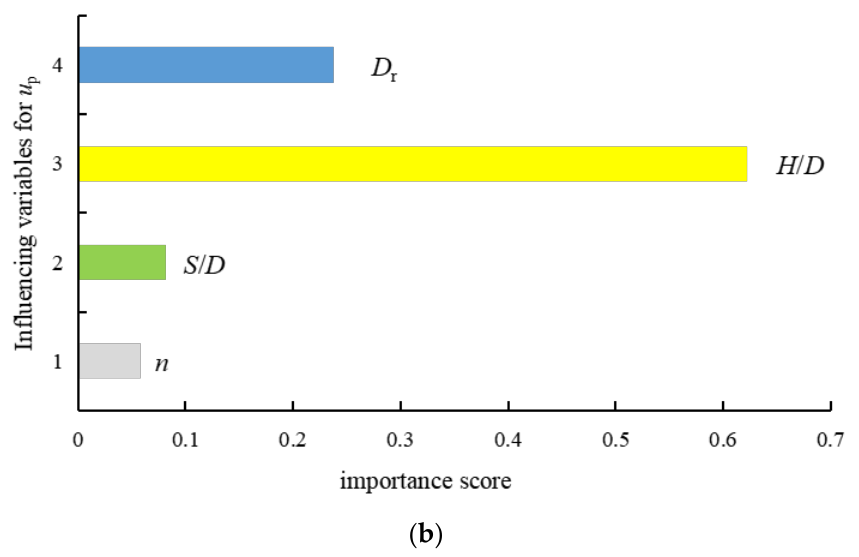
Figure 11. Importance score of influencing variables (1: n ; 2: S / D ; 3: H / D ; 4: D r ): ( a ) Q u , ( b ) u p.